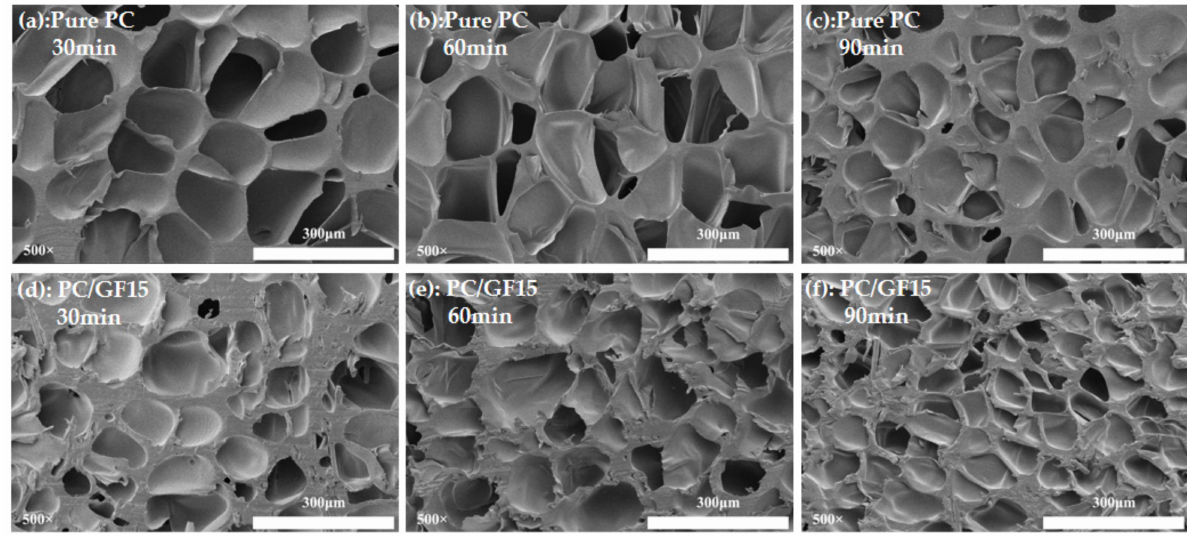
Figure 12. SEM micrographs of foamed PC and PC/15 % GF at different saturation times. PC ( a ) 30 min, ( b ) 60 min, ( c ) 90 min. PC/15%GF ( d ) 30 min, ( e ) 60 min, ( f ) 90 min.